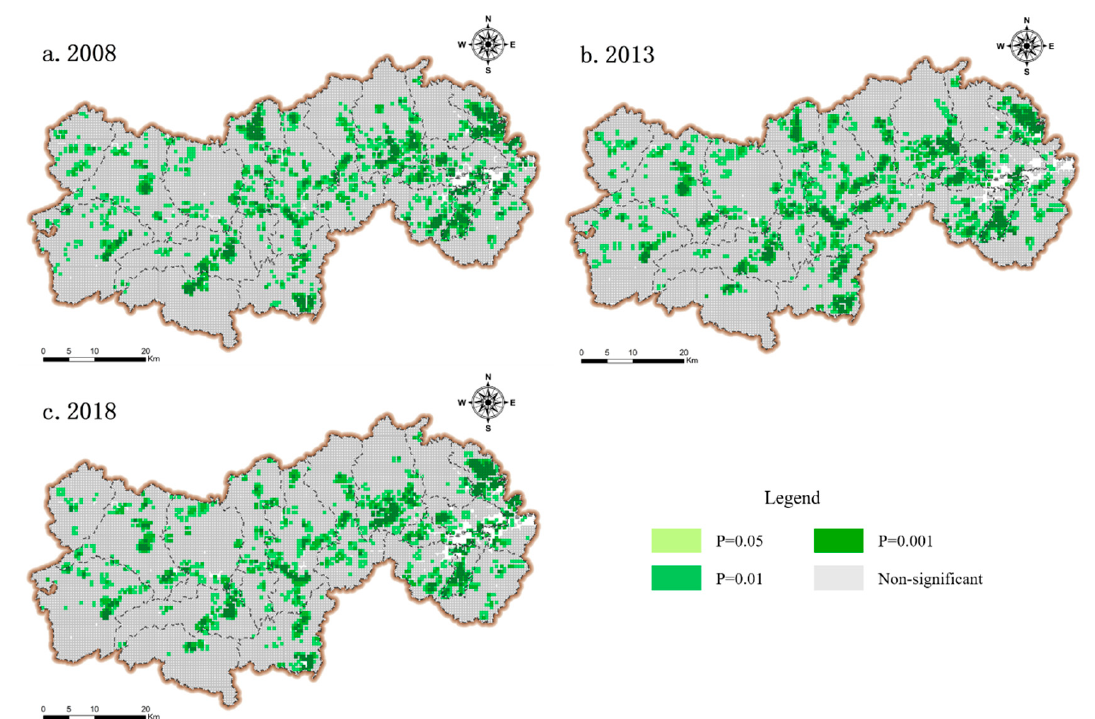
Figure 4. Local spatial autocorrelation of potential land-use conflict in Lin’an District, 2008–2018. ( a ) 2008. ( b ) 2013. ( c ) 2018.